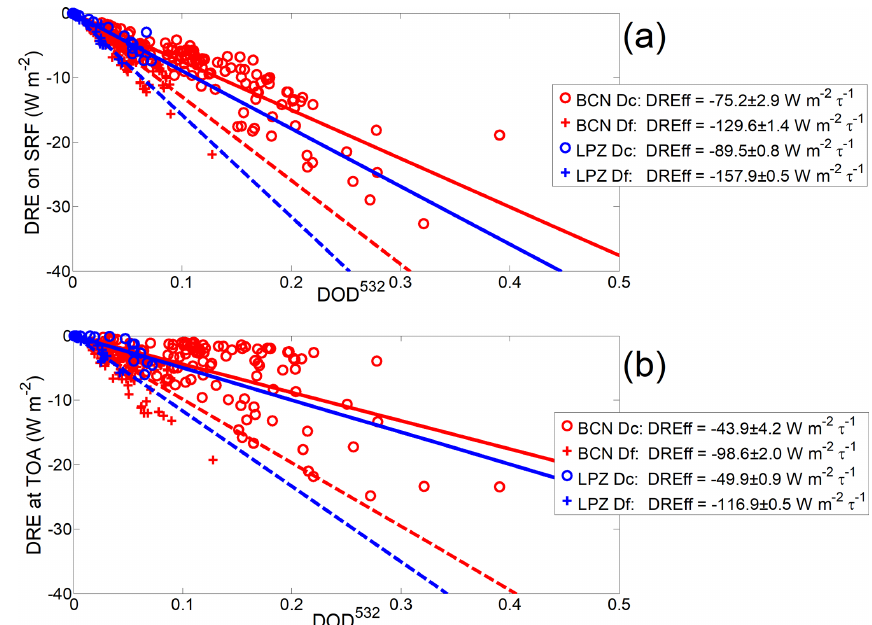
Figure 8. Dust direct radiative effect (DRE) (a) on the surface (SRF) and (b) at TOA as a function of DOD at 532nm (DOD 532 ), as shown separately for the coarse dust (Dc; circles, solid lines) and fine dust (Df; crosses, dashed lines) components at both BCN (23–30 June) (in red) and LPZ (29 and 30 June) (in blue). Corresponding DREff values (slope of the linear fitting: DRE vs. DOD) are included in the legend, as well as their standard deviation (i.e. the standard deviation of the points from the best linear fit).